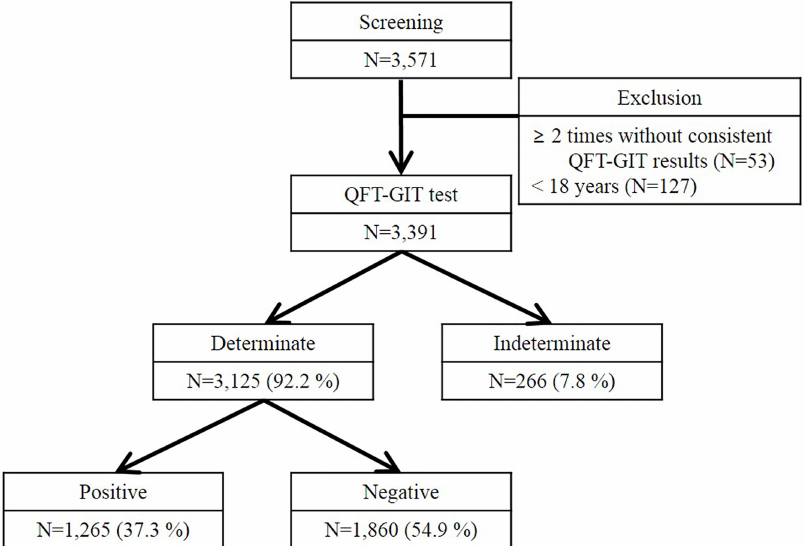
Fig 1. Flow chart of the study protocol. We screened 3,571 subjects who underwentQuantiFERON-TB Gold In-Tube testing (QFT-GIT) testing more than once. Of these subjects, patients who were under 18 years old (n = 127) or who underwent QFT-GIT more than twice without consistent results (n = 53) were excluded. After exclusion,3,391 patients were enrolledin the study in which 1,265 (37.3%) had a positive QFT-GIT result, 266 (7.8%) had an indeterminate result, and 1,860 (54.9%) had a negative result.